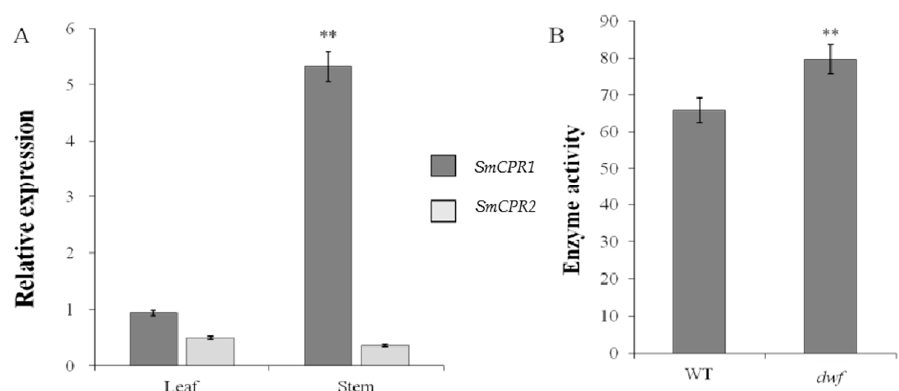
Figure 5. Relative expression and enzyme activity: ( A ) Expression pattern of SmCPR1 and SmCPR2 in leaves and stems; ( B ) CPR enzyme activity assayed in the stems of WT and dwf .